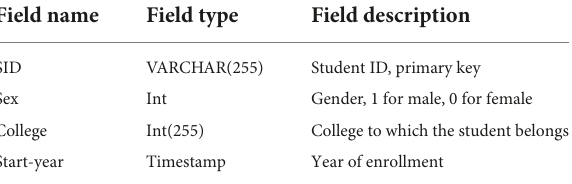
TABLE 2 Field description of student basic information